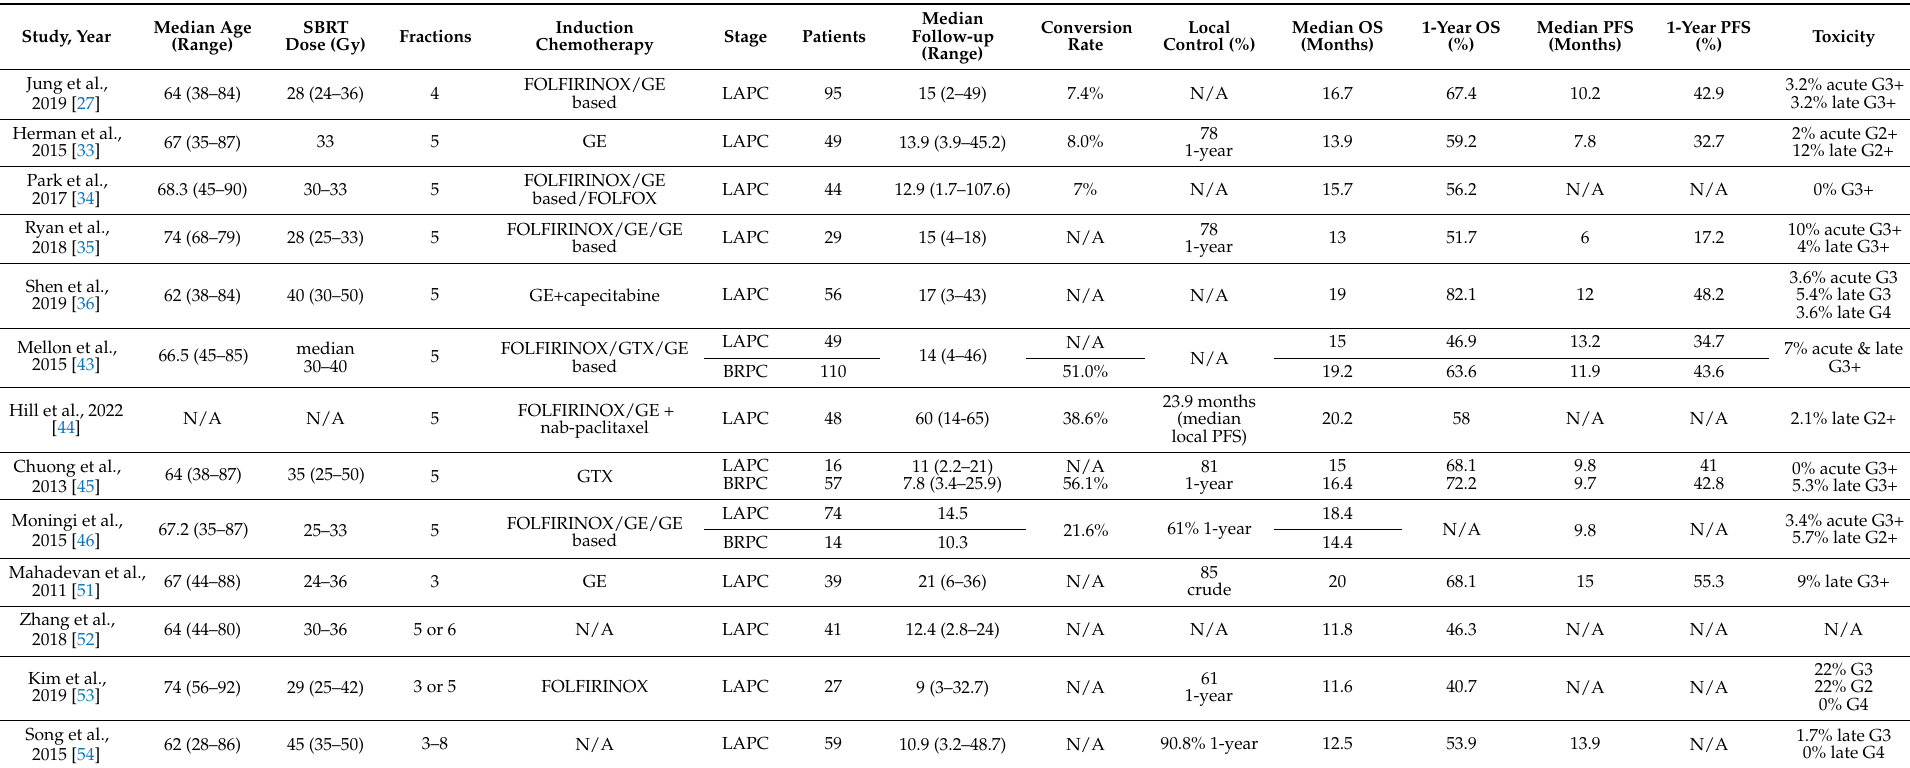
Table 1. Finalized studies using SBRT for treatment of pancreatic